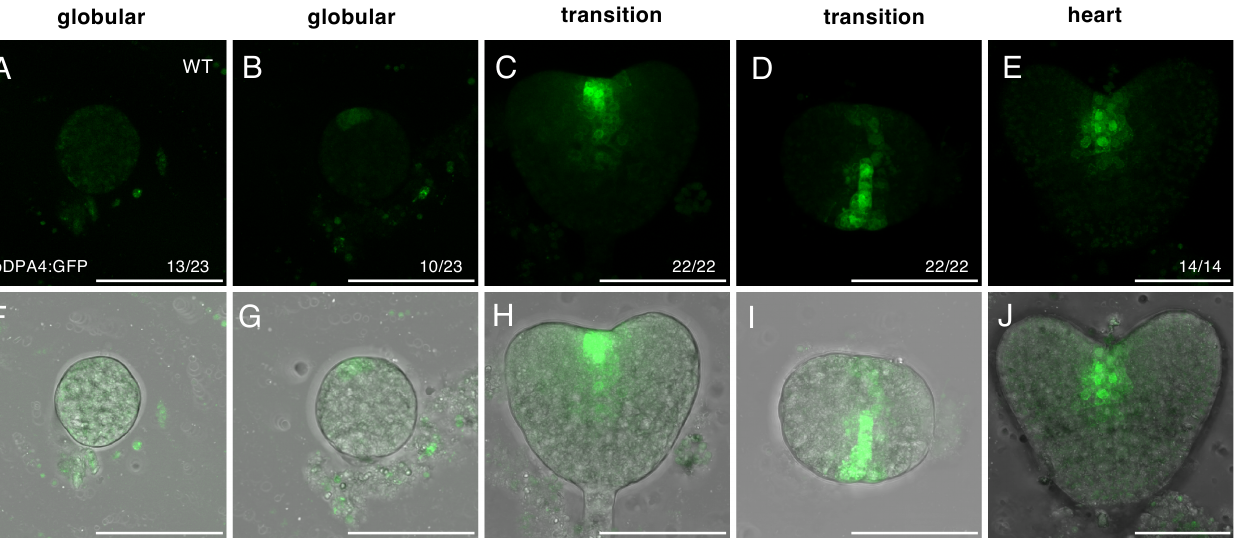
Figure 3. pDPA4:GFP expression in developing wild-type embryos. Panels ( A – E ) show the pDPA4:GFP signal (in green), while panels ( F – J ) show overlays of the pDPA4:GFP signal (in green) and the transmission picture (in grey). Images are maximum projection form stacks of confocal images. The number of similar observations out of the total number of observations is shown in the lower right corner as a fraction. The embryo stage is indicated above the panels. For the globular stage, an embryo without or with pDPA4:GFP expression are shown ( A , F and B , G , respectively). For the transition stage a longitudinal ( C , H ) and a transverse ( D , I ) section is shown. Scale bars = 50 µ m.